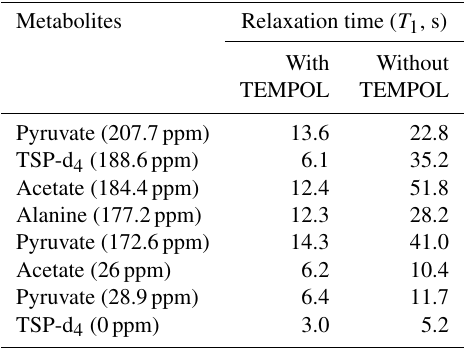
Table 2. T 1 values of metabolites in D 2 O in the presence and ab- sence of